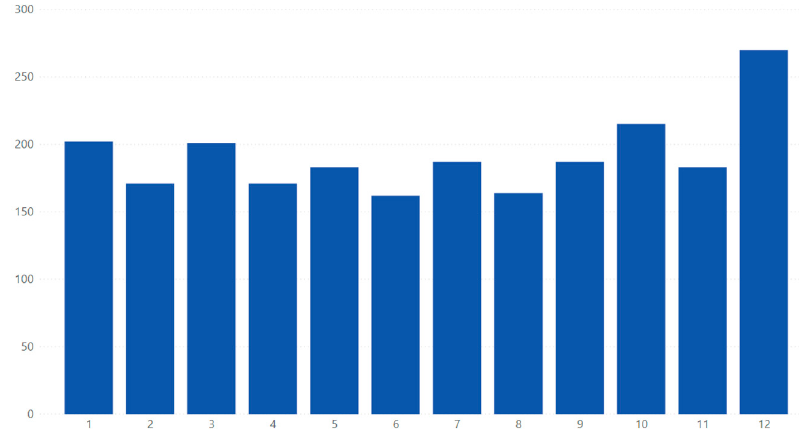
Figure 7. Number of industrial incidents per month of the year, where 1 is the 1st month, January, and 12th, the last, December.